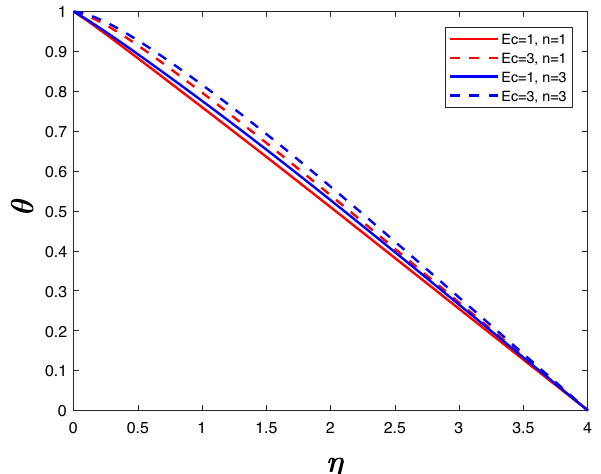
Figure 11. Temperature profile for various Ec .